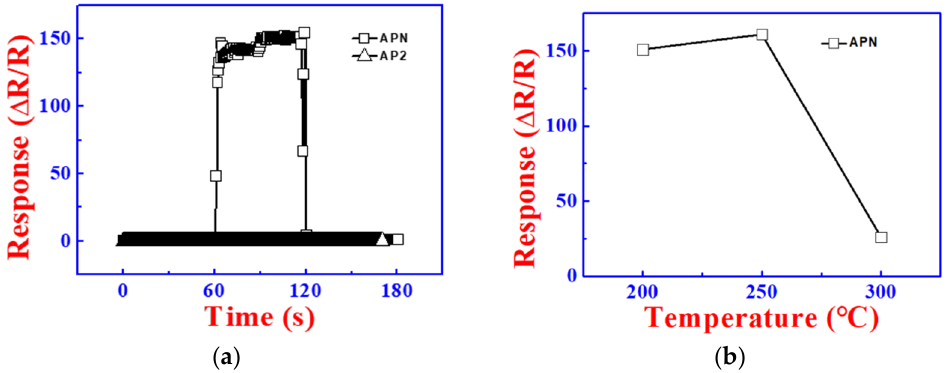
Figure 6. ( a ) The response measurement compared with the APN device and pure apple pectin device at 10 ppm ethanol, 250 °C. ( b ) Response values of the APN sensor with different temperatures at 10 ppm.